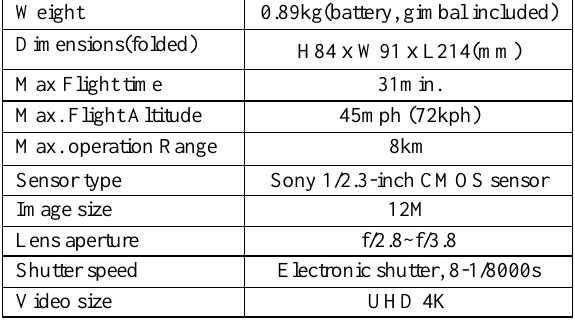
Table 2. Specifications of DJI Mavic 2 Enterprise Dual